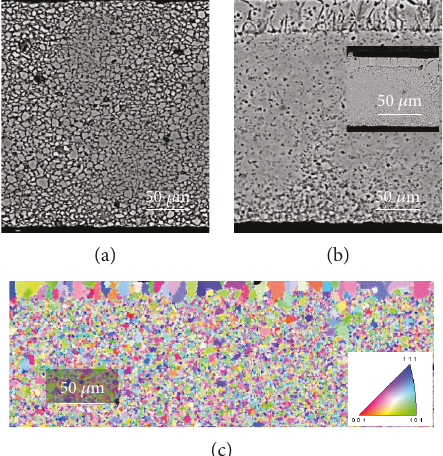
Figure 2: (a) SEM cross section image of the as-cut pc-Si sample subject to a polishing; (b) SEM cross section image of the laser- crystallized pc-Si sample (at a power density of 13.5 kWcm − 2 ) and the inset showing another region; (c) cross-sectional EBSD mapping of the laser-recrystallized pc-wafer (at a power density of 13.5 kWcm − 2